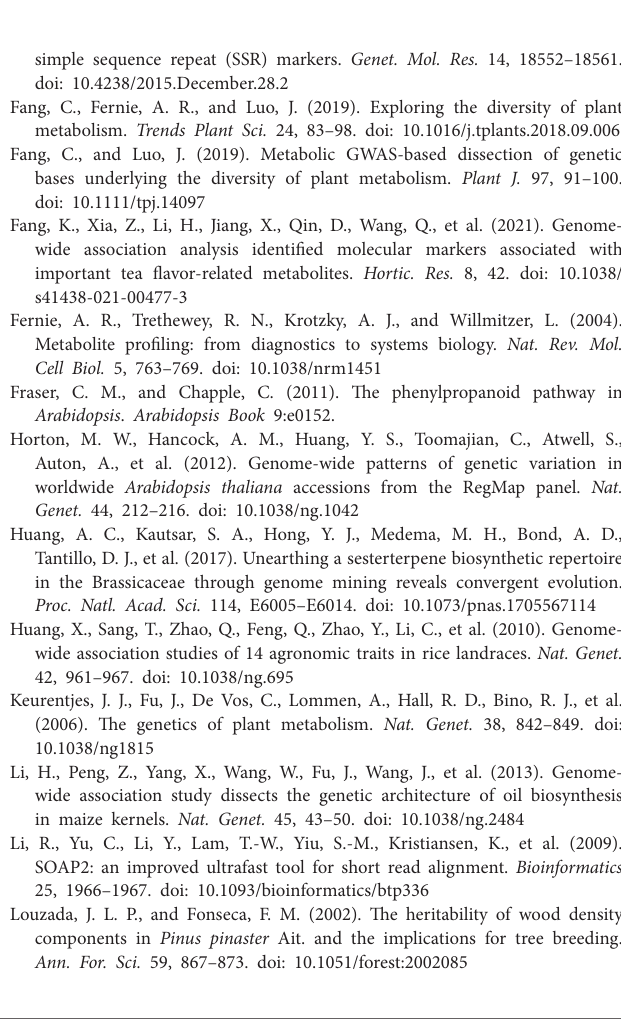
Supplementary Table S1 | The variance components and the generalized heritability of various characters in associated group. Supplementary Table S2 | The SNP